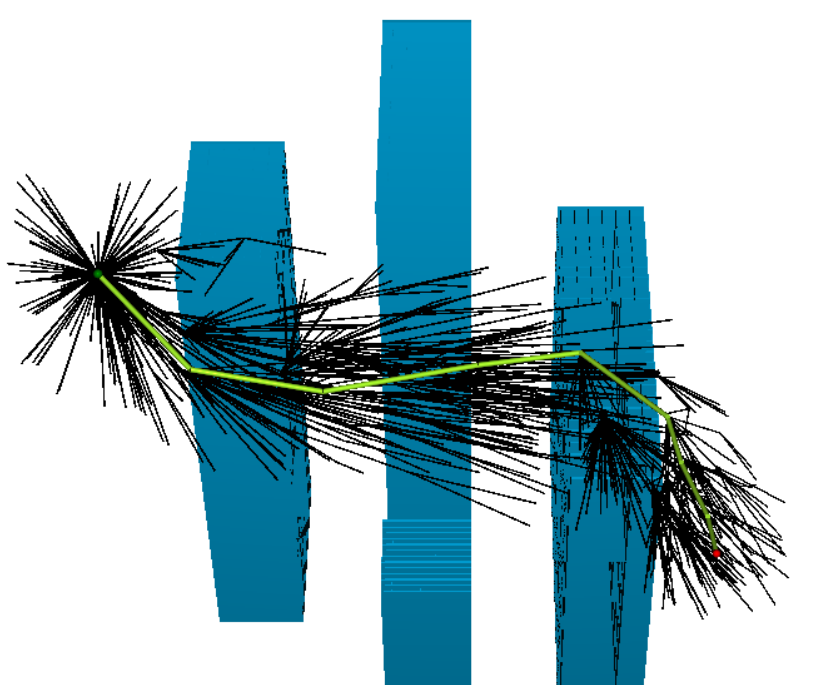
Figure 19. Example of the result of the improved FMT algorithm with four different obstacles: first step number of samples = 3000, second step number of samples = 1500, computing time = 1123.6 ms. The generated graph is drawn in black, the obstacles in blue and the path (start point in green and end point in red) in green.